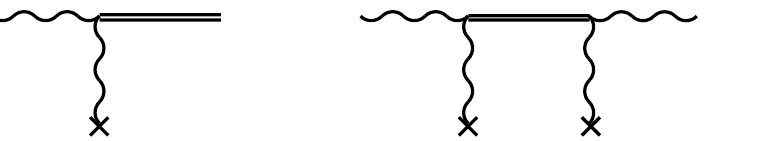
Figure 3. Axion-like particle interaction with two photons through the Primakoff effect [28]. ( Left ) first order production. ( Right ) second order